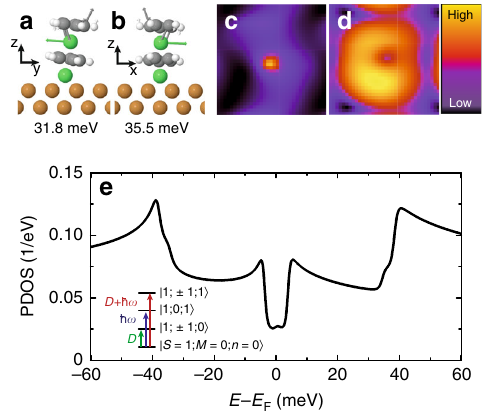
Fig. 3 Active vibrational modes and simulated spectrum of NiNc. a , b Calculated vibrational modes close to ∣ ϵ 2 ∣ . c Computed ratio between the inelastic and elastic tunneling conductance using the 35.5 meV mode. The maximum change represents 5% of the elastic conductance and is located in the center of the molecule. d Calculated local density of states of a NiNc complex at the Fermi level. e Projected density of states (PDOS) on the occupied molecular orbital as a function of electron energy calculated from Eq. (2). In the tunneling regime, the differential conductance is proportional to the PDOS 42 . Inset: State diagram of a NiNc complex based on Eq. (2); the eigenstates are noted as S ; M ; n j i and the arrows depict the three transitions leading to the excitation steps in the d I /d V